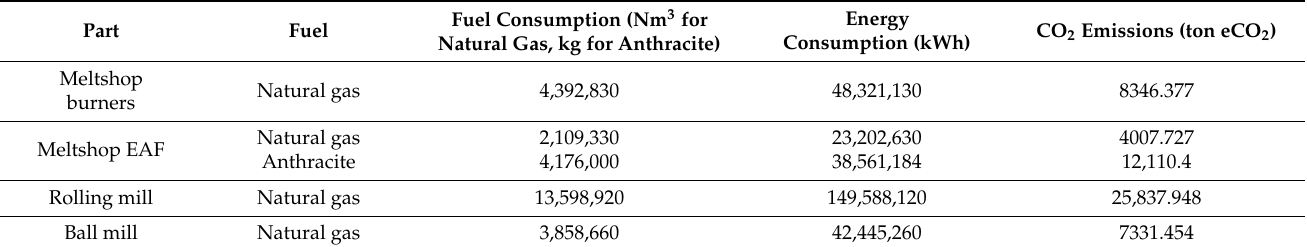
Table 2. Reference values.